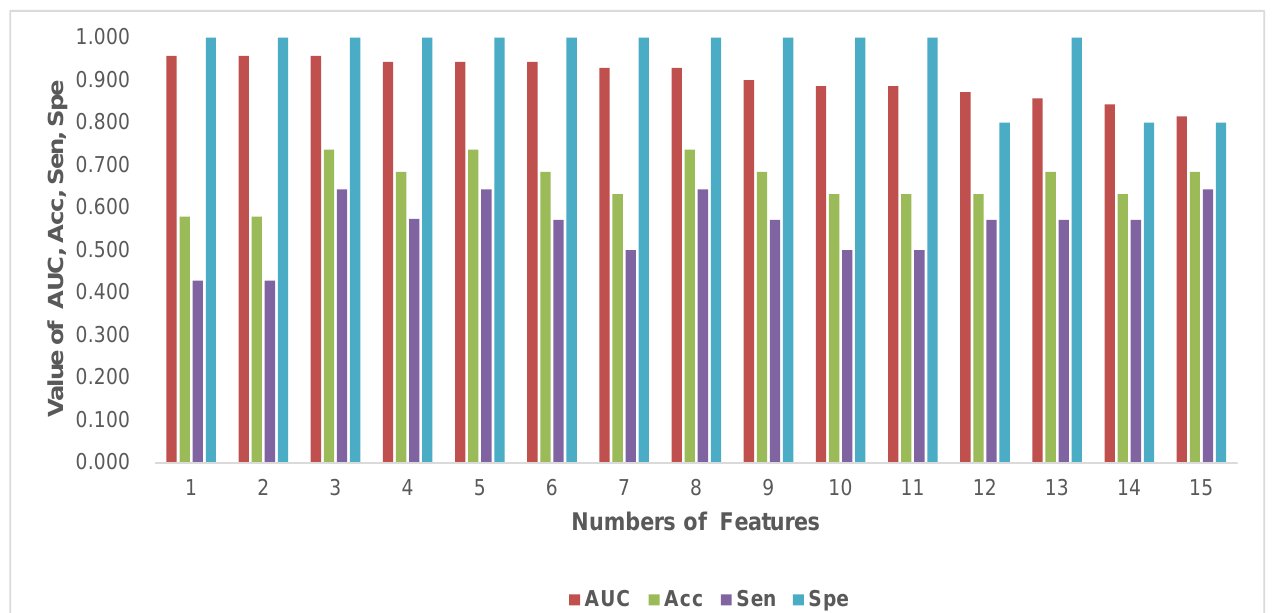
Figure 7. The performance with a different number of features, ranging from 1 to 15. This result was generated by the following radiomic pipeline settings: wavelet image filter, mean data normalization, PCC dimension reduction, RFE feature selection, and the SVM classifier with a number of features ranging from 1 to 15. Abbreviations: AUC, area under the curve; Acc, accuracy; Sen, sensitivity; and Spe, specificity.